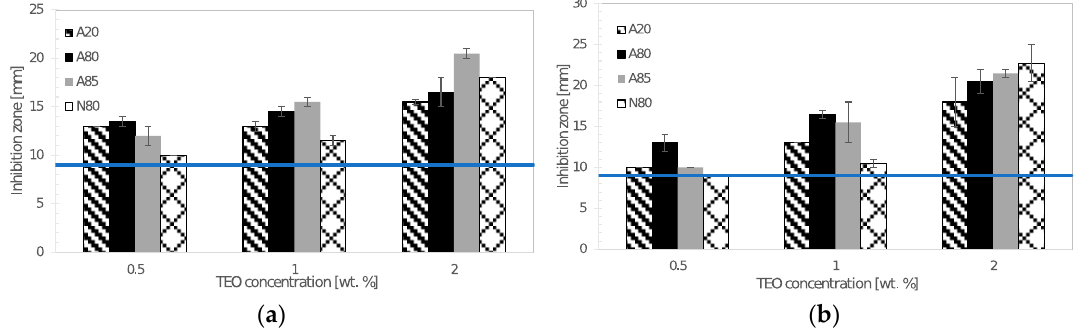
Figure 6. Inhibition zones of chitosan films against ( a ) Staphylococcus aureus and ( b ) Bacillus cereus . The straight line indicates the control chitosan sample.